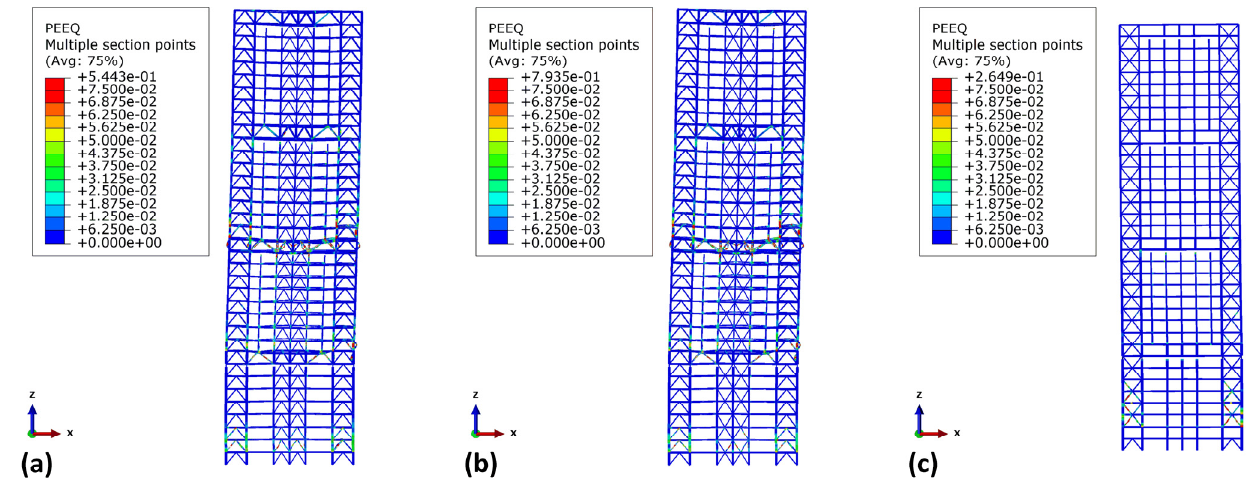
Figure 8. Equivalent plastic strain nephogram: ( a ) configuration 1, ( b ) configuration 2, and ( c ) configuration 30.